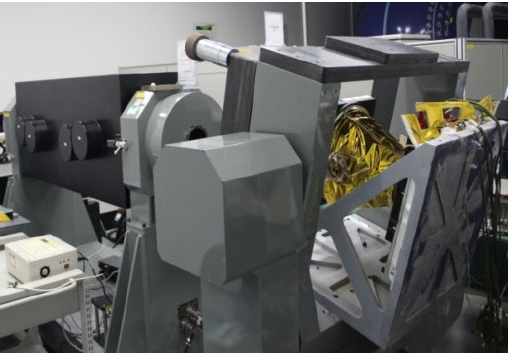
Figure 10. Polarimetric calibration accuracy validation experiment with